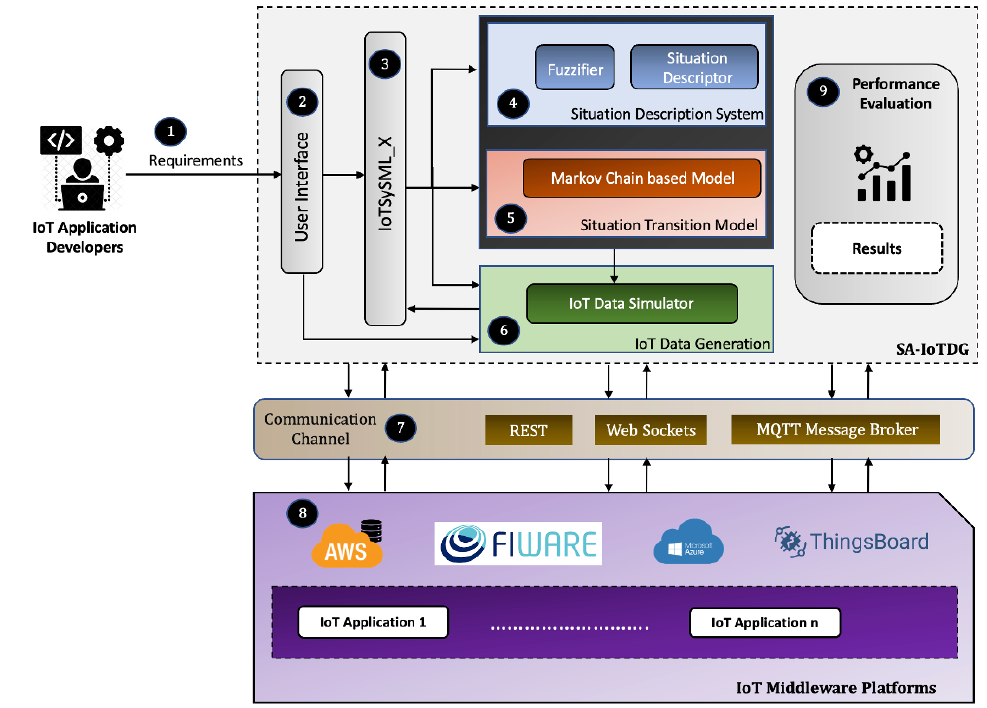
Figure 2. High-level System